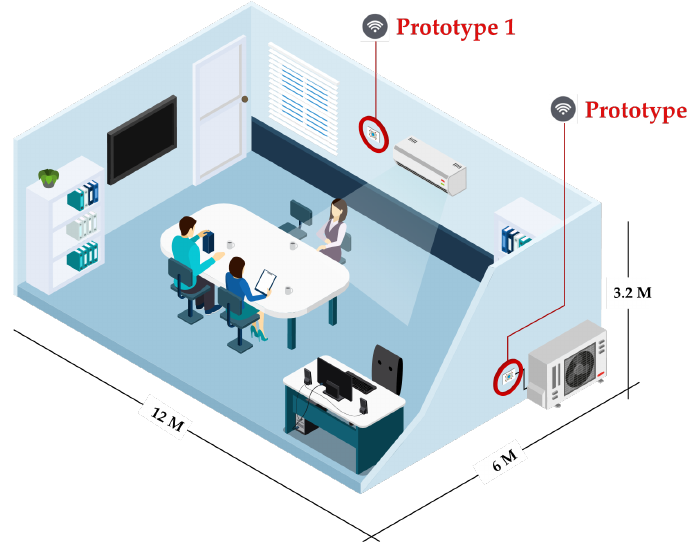
Figure 3. Installation of IoT-based measurement for thermal comfort in indoor environment .